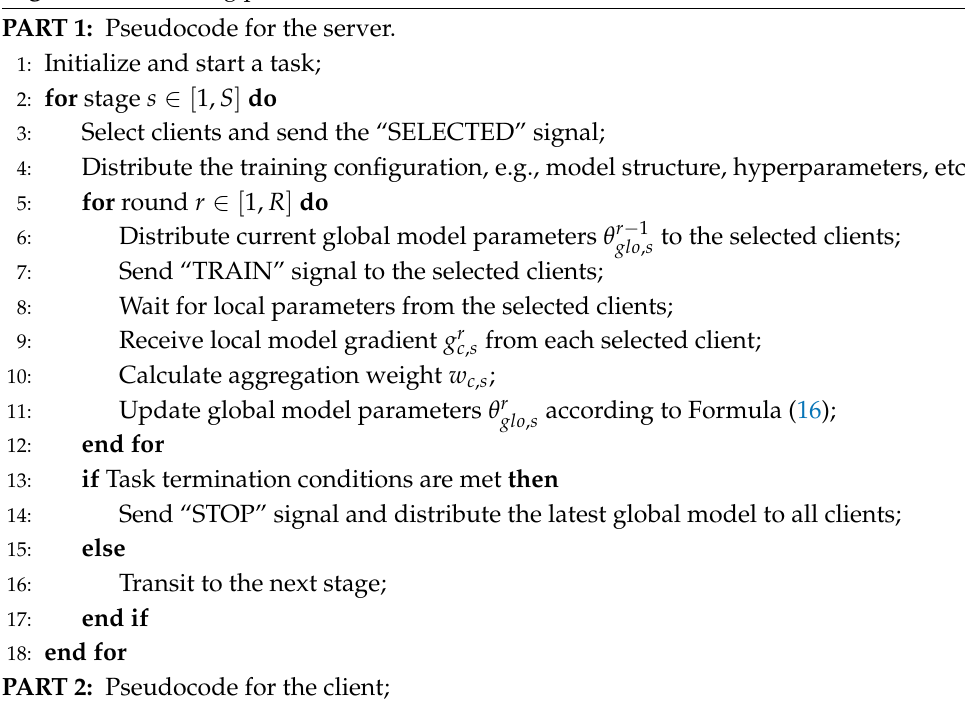
Algorithm 1 Training phase of